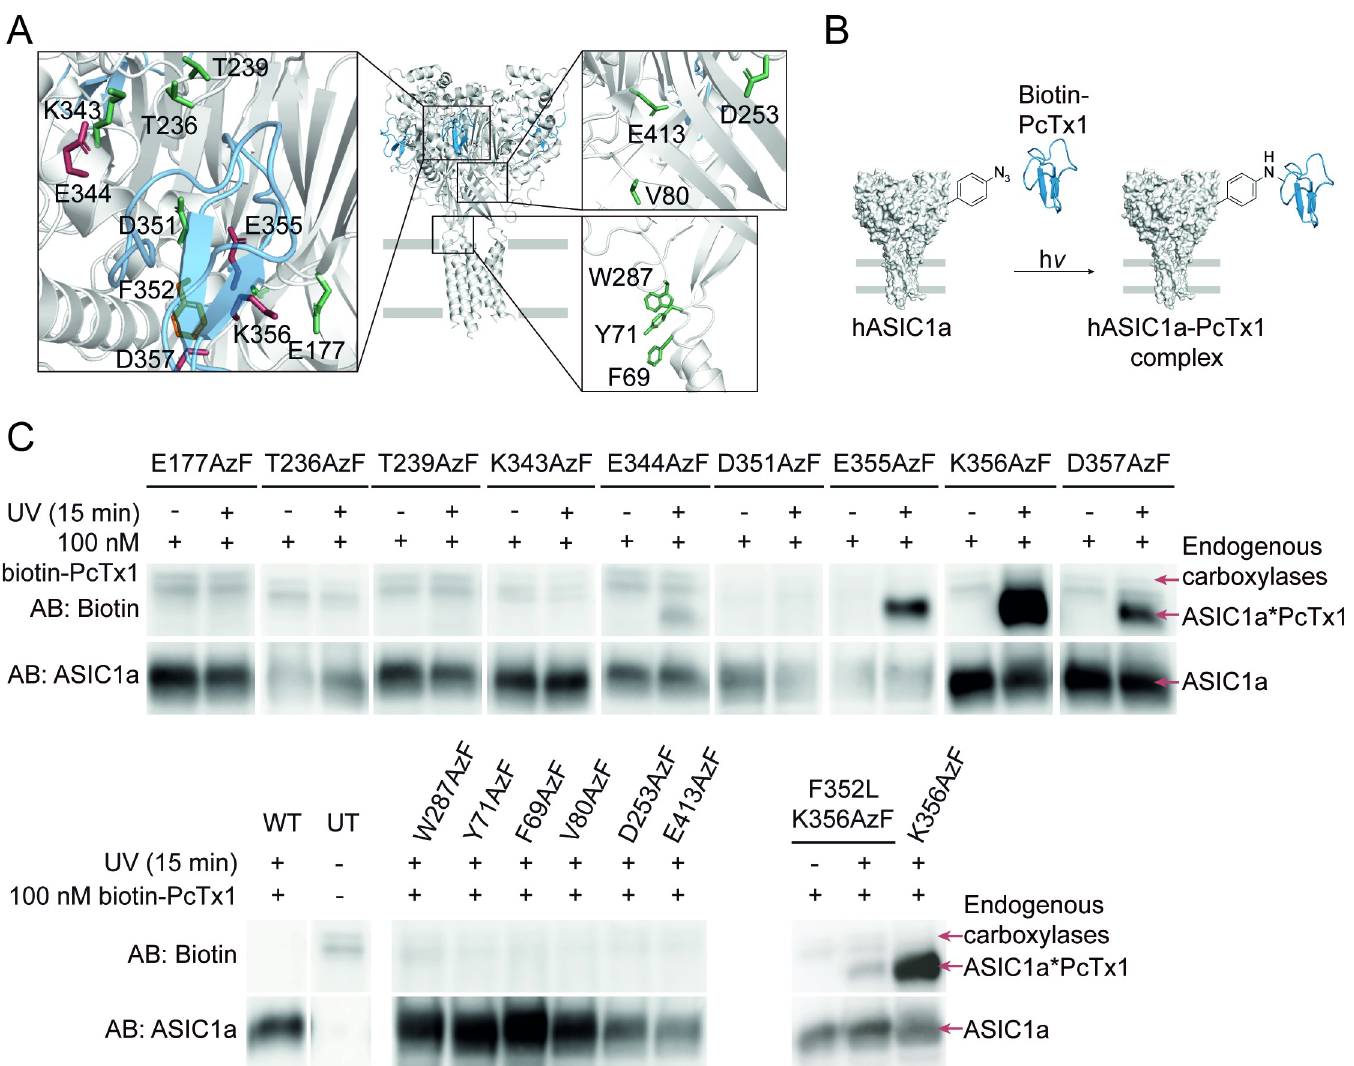
Fig 5. Live-cell photocrosslinking delineates the PcTx1 binding site at the ASIC1a acidic pocket. (A) Structure of cASIC1 (white) in complex with PcTx1 (blue, PDB: 4FZ0), insets show individual side chains replaced by AzF in the acidic pocket (left inset) and lower ECD (right insets). Positions that crosslinked to biotin-PcTx1 are colored red, F352 is marked in orange, and positions that did not crosslink are colored green. (B) Schematic workflow for crosslinking to biotin-PcTx1. HEK 293T ASIC1a-KO cells expressing AzF-containing hASIC1a variants are incubated with 100 nM biotin-PcTx1 and exposed to UV light for 15 minutes to form covalent hASIC1a–PcTx1 complexes, which are purified via a carboxyl-terminal 1D4-tag on hASIC1a and visualized via western blotting. (C) Western blot of purified hASIC1a WT, UT cells, and variants carrying AzF in the ECD detected using the specified AB. Biotin-PcTx1 is detected in UV-exposed samples containing AzF at positions 344, 355, 356, and 357 in the acidic pocket (colored red in A, left inset), but not at positions 177, 236, 239, 343, or 351 (colored green in A, left inset). PcTx1 is also absent in control samples not exposed to UV, those carrying AzF in the lower ECD (right insets in A), WT, or UTs. PcTx1 can be detected upon UV-exposing the toxin-insensitive F352L K356AzF double mutant (left inset in A, F352 colored orange). Of note, the anti-biotin AB detects endogenous biotin-dependent carboxylases, which are also found in purified samples from UTs and have been described before [55,56].Data are representative of 3 individual experiments; see S12–S15 Figs for original blots and crosslinking attempts with Bpa. The underlying data have been deposited at zenodo.org (https://doi.org/10.5281/zenodo.4906985; files 12 and 13). AB, antibodies; ASIC1a, acid-sensing ion channel 1a; AzF, 4-Azido-l-phenylalanine; Bpa, 4-Benzoyl-l-phenylalanine; cASIC1, chicken acid-sensing ion channel 1; ECD, extracellular domain; hASIC1a, human acid-sensing ion channel 1a; PcTx1, psalmotoxin 1; PDB, Protein Data Bank; UT, untransfected; WT, wild type. positions containing AzF in the lower ECD (F69, Y71, V80, D253, W287, and E413), as well as in samples containing AzF in the acidic pocket not exposed to UV light (Fig 5C). By contrast, PcTx1 was detected at 4 out of 9 AzF-containing positions (344, 355, 356, and 357) after UV